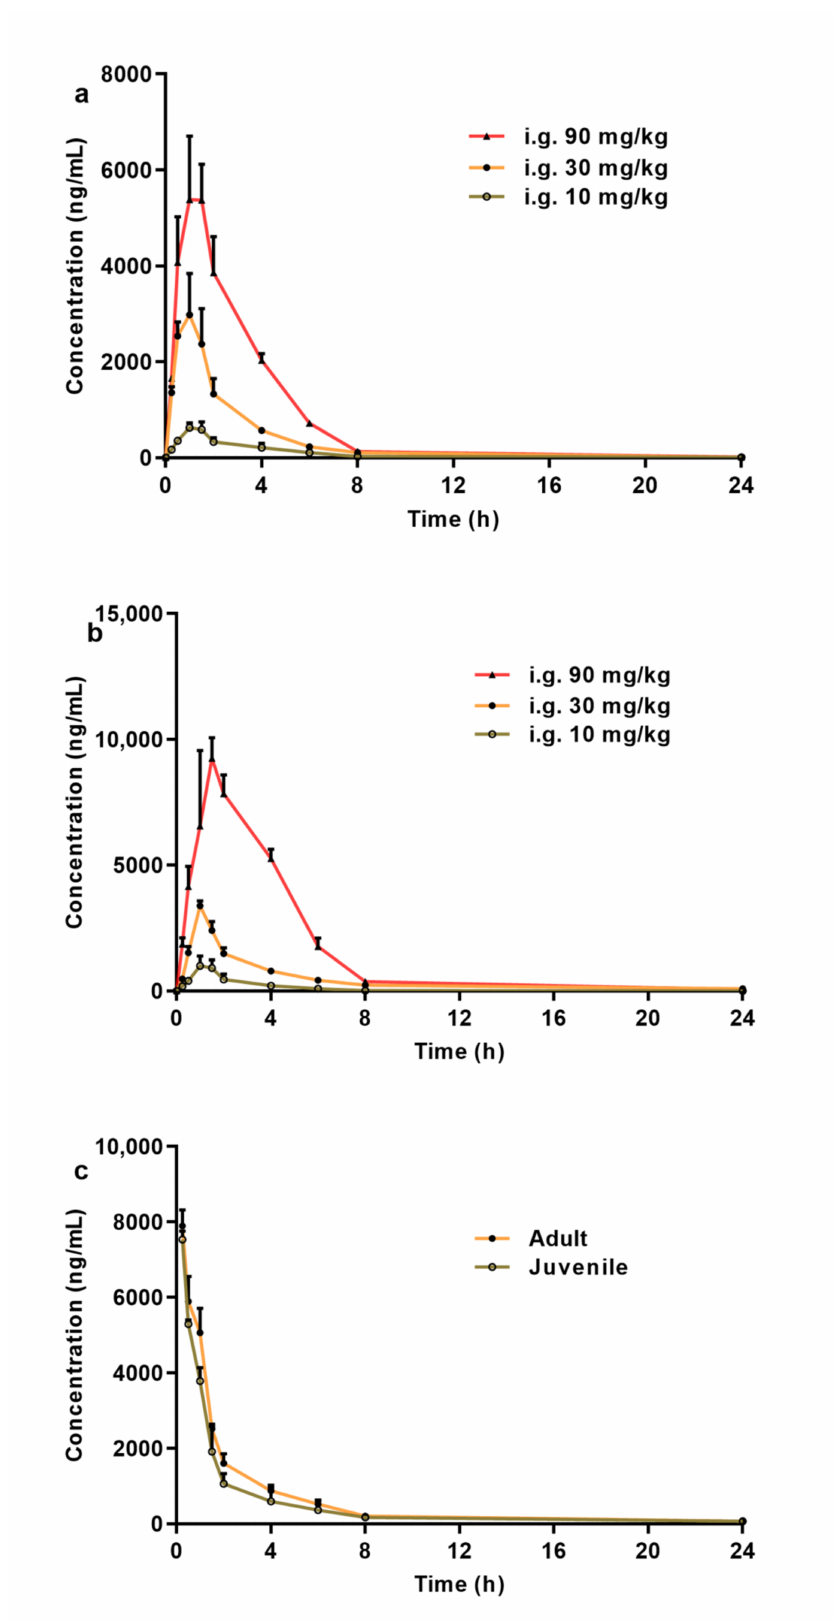
Figure 2. ( a ) Mean plasma concentration–time curves following the oral administration of CPPU in adult rats. ( b ) Mean plasma concentration–time curves following oral administration of CPPU in juvenile rats. ( c ) Mean plasma concentration–time curves following intravenous administration of CPPU in both adult and juvenile rats. CPPU—1-(2-chloro-4-pyridyl)-3-phenylurea,